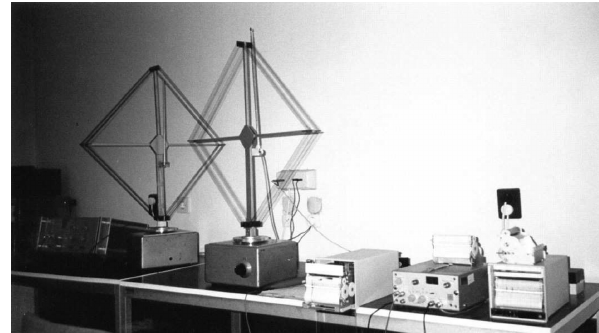
Figure 13. Frame antennas and recording devices used for the mea- surement of the ionospheric absorption of radio waves. (Re-printed from Bencze, 2001, Fig.